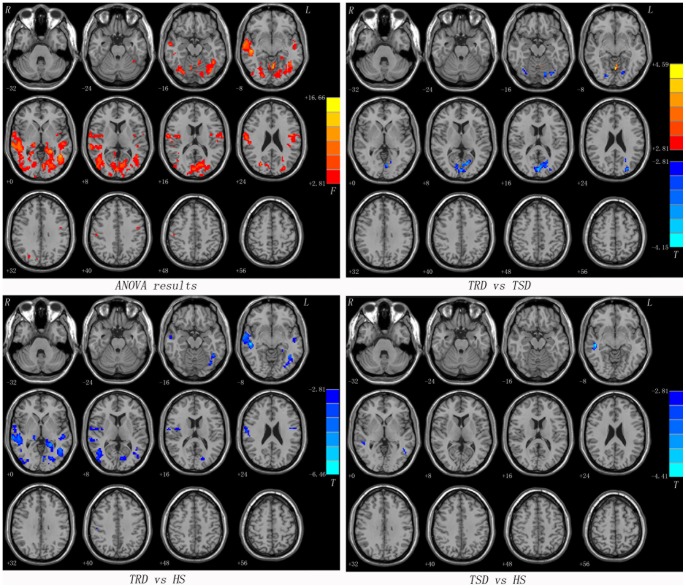
Statistical maps showing seed-based FC differences between subject groups (seed: the right calcarine cortex).Red denotes FC differences in the ANOVA analyses and the color bar indicate the F value from the ANOVA analyses. Red and blue denote higher and lower FC respectively and the color bars indicate the T value from post hoc analysis between each pair of groups. Of note, the two-sample t-test results within a mask showed significant group differences in the ANOVA analysis. FC = functional connectivity, TRD = treatment-resistant depression, TSD = treatment-sensitive depression, HS = healthy subjects.